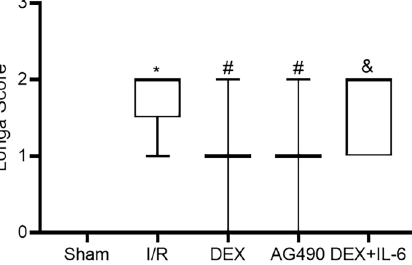
Figure 2. Neurological de fi cits were evaluated by the Longa score. Data are reported as median (interquartile range), n=25/ group. *P o 0.05 vs Sham group; # P o 0.05 vs I/R group; & P o 0.05 vs DEX group (nonparametric Kruskal-Wallis test). I/R: ischemia/ reperfusion; DEX: dexmedetomidine; IL-6: interleukin-6.